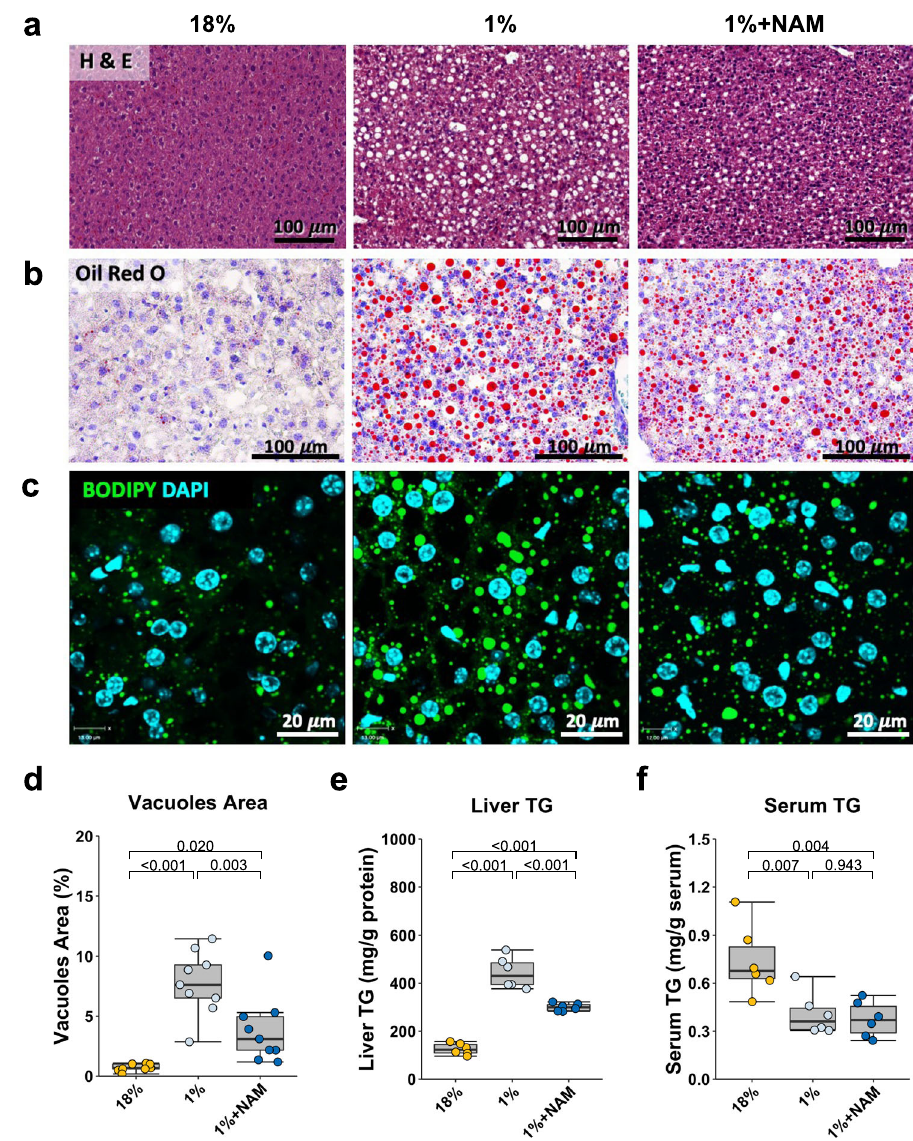
Fig. 2 | Theeffect of1% protein feeding with orwithout NAM supplementation on hepatic lipid accumulation. a Representative hematoxylin and eosin staining images of the liver (×20 magni fi cation). Cytoplasm was stained in red, and the nucleus was stained in purple ( n =5 replicates). b Representative oil red o stain stainingimagesof theliver(×20magni fi cation).Fatdropletwasstainedinred,and nucleus was stained in purple ( n =3 replicates). c Representative immuno- fl uorescence images of the liver (×40 magni fi cation). BODIPY was used to stain fat